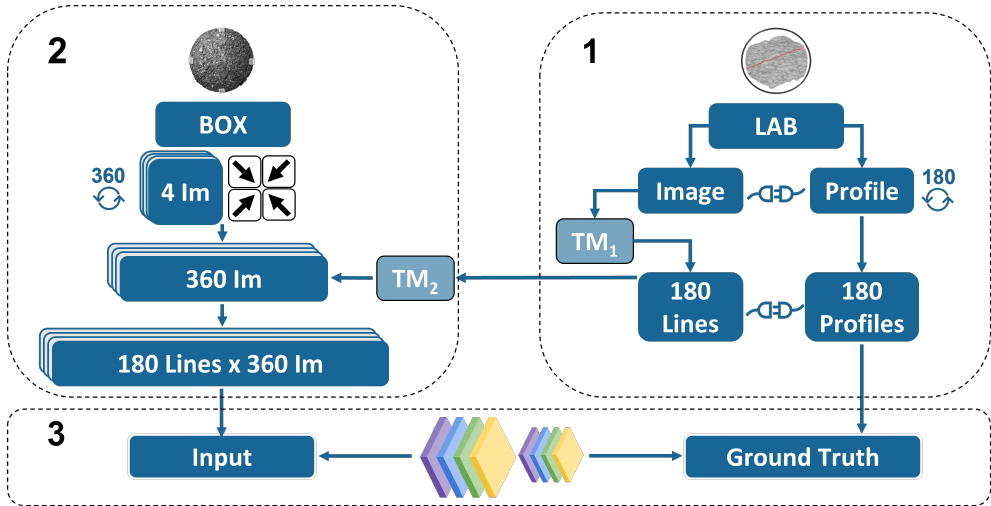
Figure 2. Overall methodology chart. ( 1 ) Laboratory laser profiles. ( 2 ) Images inside box. ( 3 )